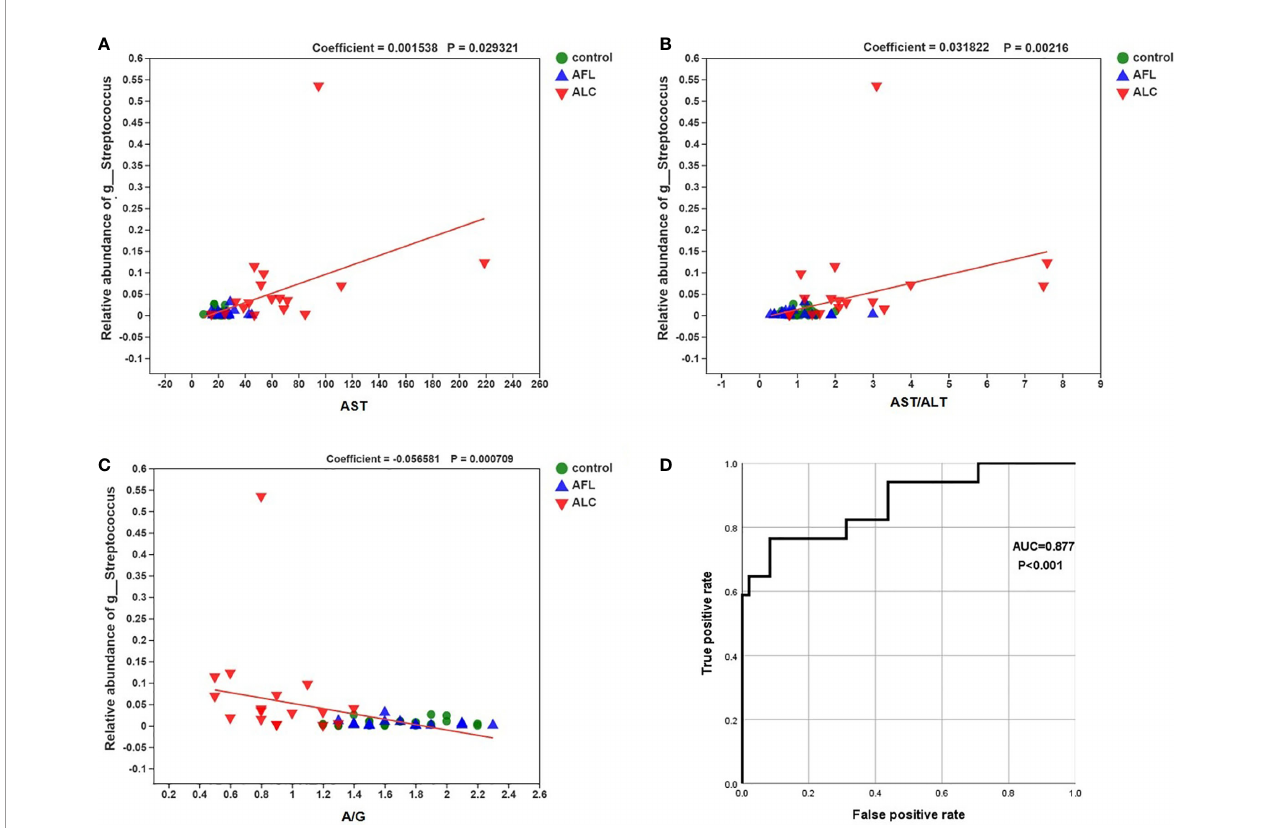
FIGURE 5 | Correlations between the relative abundance of Streptococcus and the level of the speci fi c clinical factor. The correlations were calculated in MaAsLin. (A) AST (coef fi cient = 0.0015, p = 0.029), (B) AST/ALT (coef fi cient = 0.0318, p = 0.002) and (C) A/G ( – 0.0566, p = 0.0007). (D) the ROC curve about the relative abundance of Streptococcus and